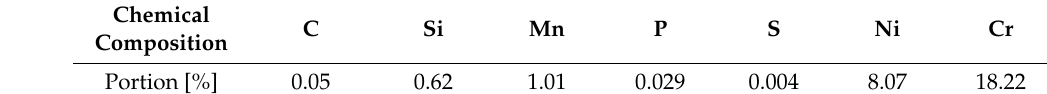
Table 1. Chemical composition of UNS S30400 [14,15].